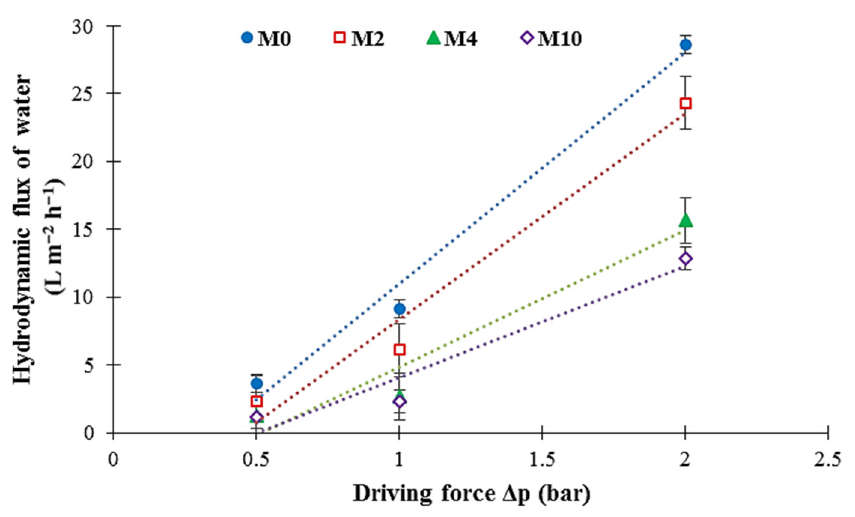
Figure 10. Influence of the operating pressure on the hydrodynamic water flux for different obtained membranes.